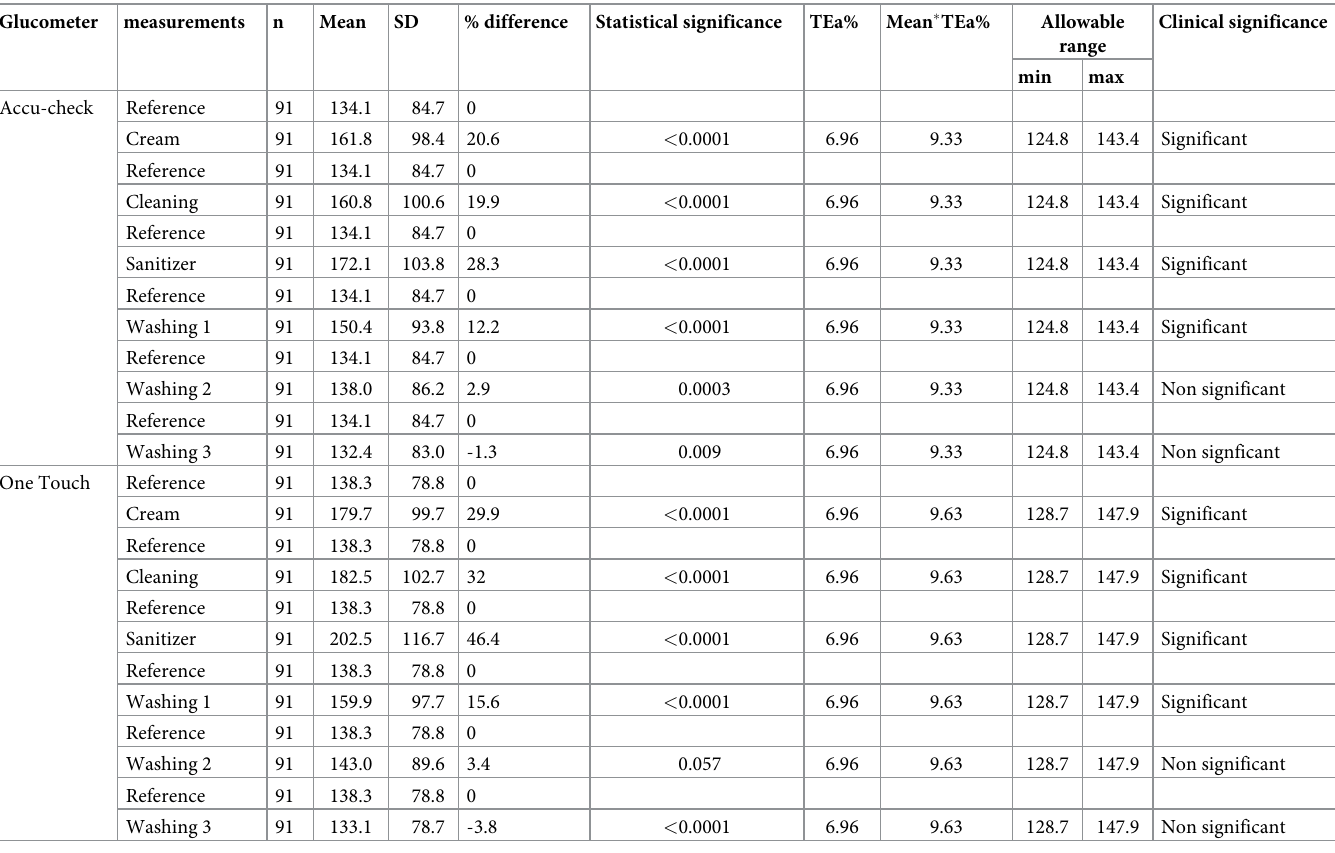
Table 3. Clinical significance of differences in glucose levels between reference and post-intervention values, using the total error